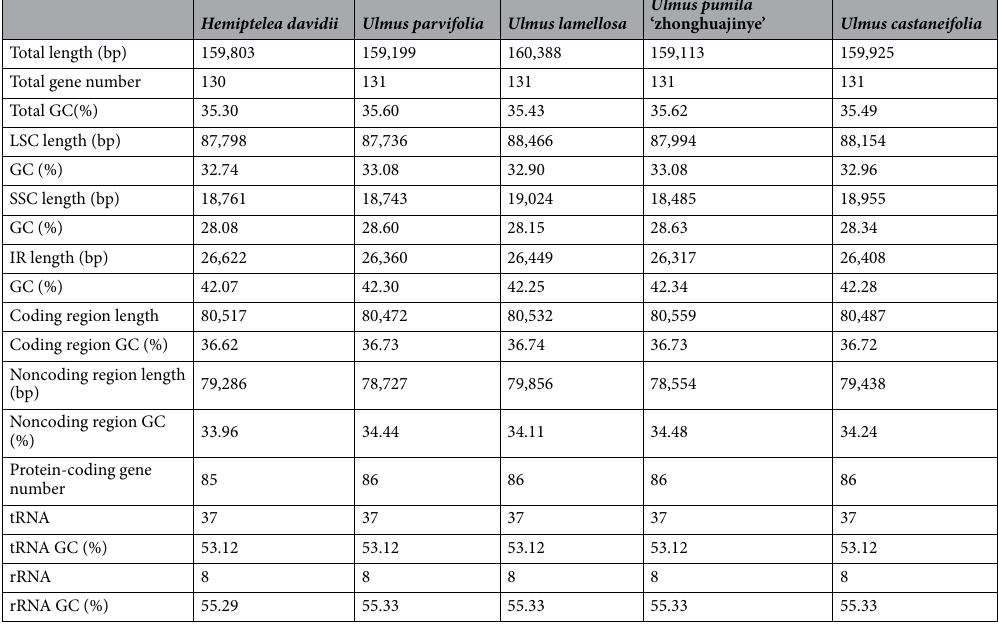
Table 1. The basic characteristics of the cp genomes of four Ulmus species and H. davidii.